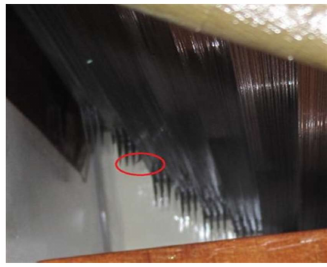
Figure 6. The fault location of the transformer as found by